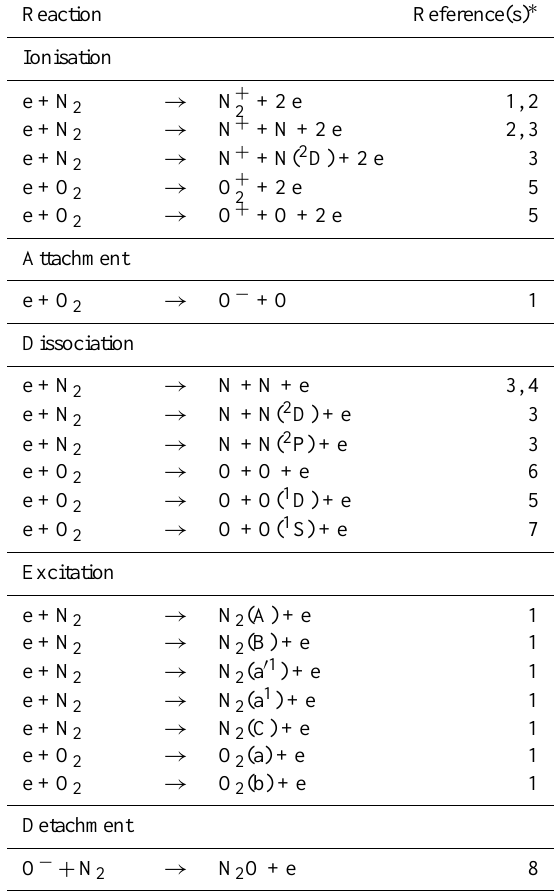
Table 2. Electric field driven processes in the model. The reaction rate coefficients as functions of the reduced electric field are calcu- lated with the Boltzmann solver BOLSIG+ (Hagelaar and Pitchford, 2005), and cross-section data from the literature. The reaction rate coefficient as a function of the reduced electric field, only for the last reaction, is directly taken from the reference.